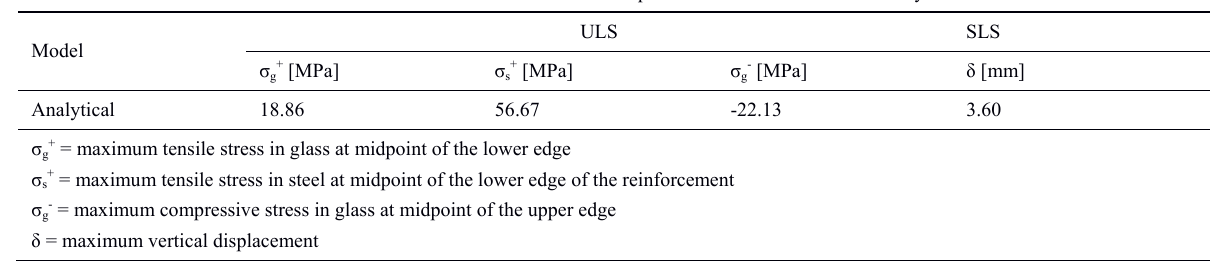
Table 6: Maximum values of stresses and vertical displacement calculated with the analytical